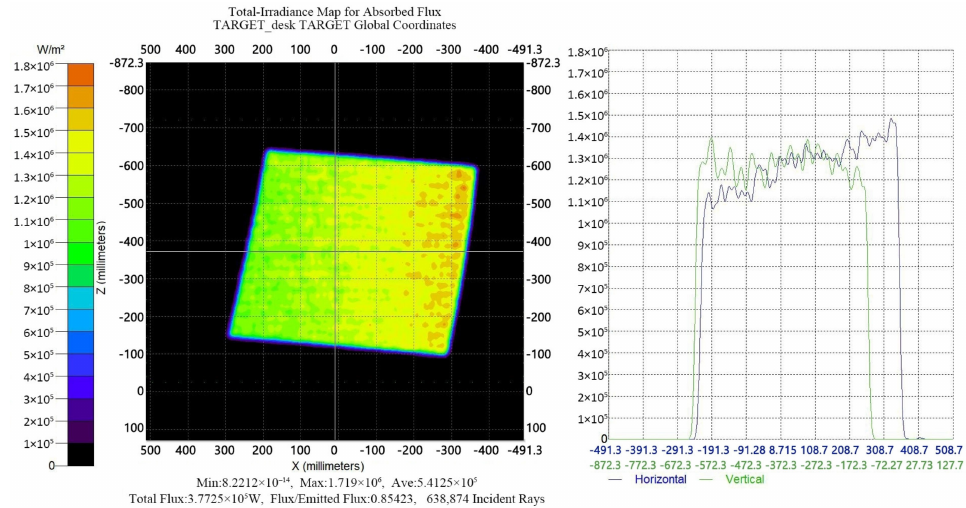
Figure 14. Illuminance map of the target plane, according to the freeform reflector design